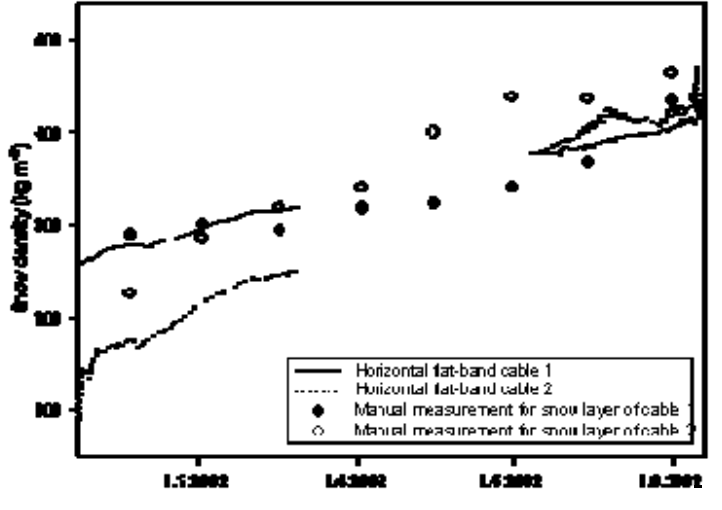
Figure 12. Measurements of snow density as a function of time. Comparison of TAUPE measurements at two different cables with manual measurements with snow